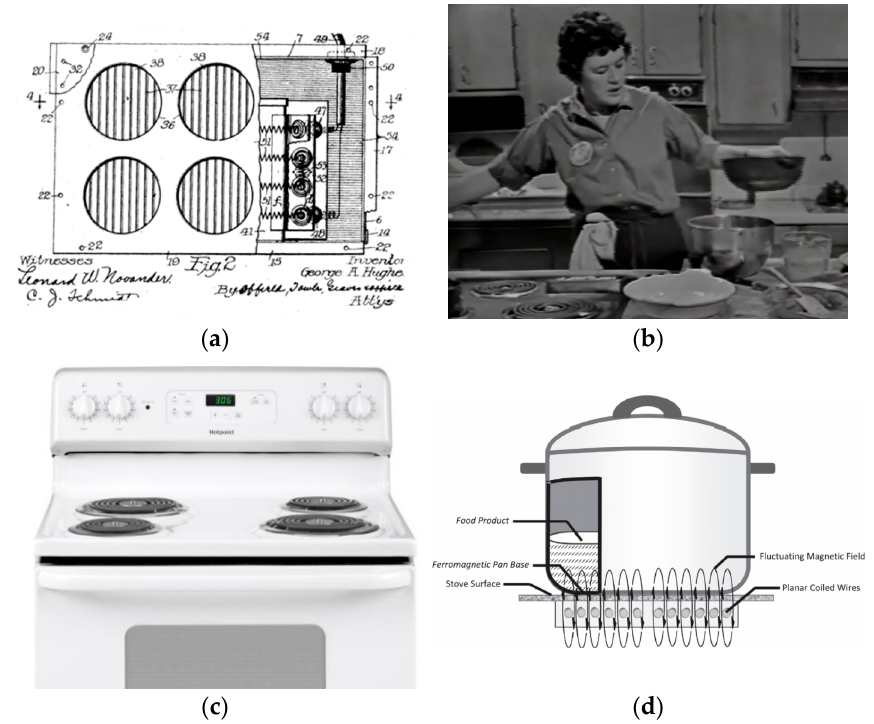
Figure 9. Historic appearance of electric cooking range: ( a ) Cooking range invented by Hughes, 1915 [135]. ( b ) Julia Child cooking with an electric range, 1963 [139]. ( c ) Electric cooking range on market, 2022. ( d ) Induction cooking schematic [140].